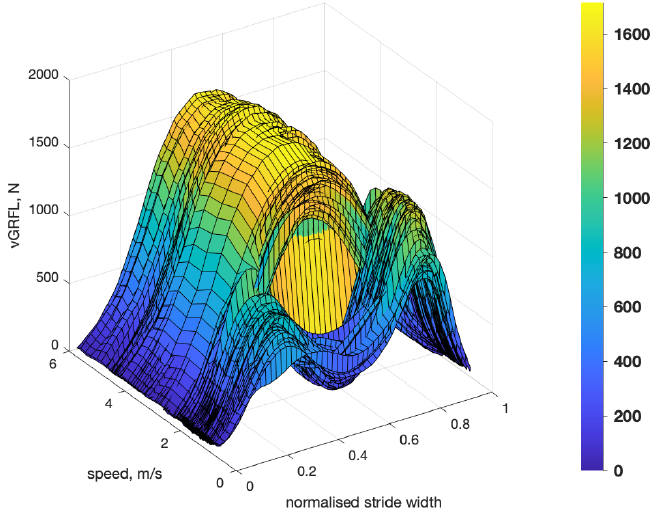
Figure 1. Example of vertical ground reaction force of left foot with respect to speed and normalized stride